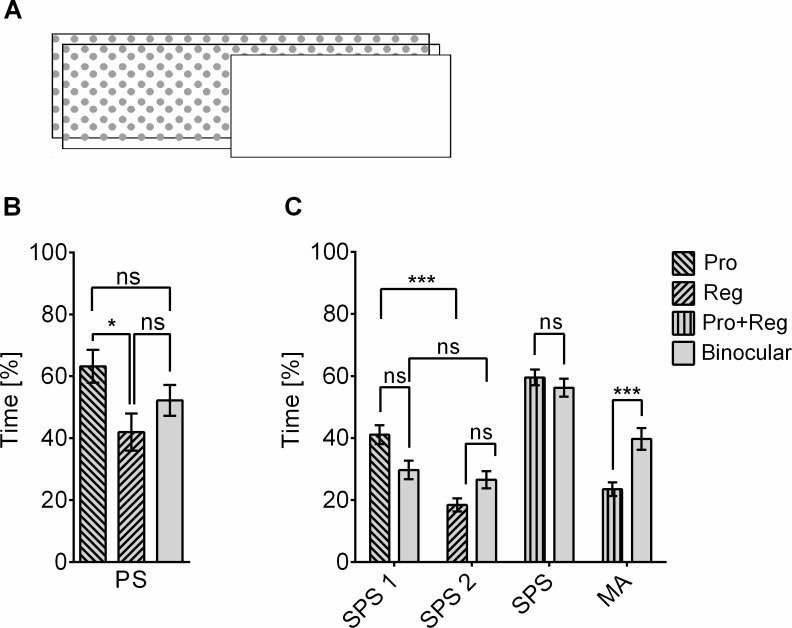
Monocular TPMP reduces SPS for regressively moving bias and MA behavior.(A), Monocular stimulation with regular dots patterns. (B), One pattern in closed loop (progressive or regressive bias, 20° per s), the other stationary (mean ± SEM, n = 20 flies per group, F(F(2, 57) = 0.4453, p = 0.0272, R2 = 0.1188, ANOVA)). Pro bias was more extensively stabilized than Reg bias (p = 0.0203, Tukey’s multiple comparisons test). Neither performance value was significantly different from PS with binocular stimulation (grey) (preg = 0.3822, ppro = 0.3289, Tukey’s multiple comparisons test). (C), In the TPMP, flies with monocular input stabilized the pro moving pattern significantly more than the reg moving one (mean ± SEM; n = 21 flies for binocular stimulus, n = 42 flies for monocular stimulus; H(3, 123) = 31.3, p < 0.0001, Kruskal-Wallis test; ppro-reg = < 0.0001, pbino1-bino2 > 0.9999; ppro-bino1 = 0.2677, preg-bino2 = 0.3702, Dunn’s multiple comparisons test). With monocular stimulation (pro+reg), MA behavior was reduced compared to binocular stimulation (binocular)(U = 401.5, p = 0.57, Mann-Whitney test), while overall SPS was not different (U = 205, p = 0.0004, Mann-Whitney test). Underlying data can be found in S1 Data and https://doi.org/10.6084/m9.figshare.4668571.v1. MA, motion average; Pro, progressive; PS, pattern stabilization; Reg, regressive; SPS, single pattern stabilization; TPMP, transparent panorama motion paradigm.